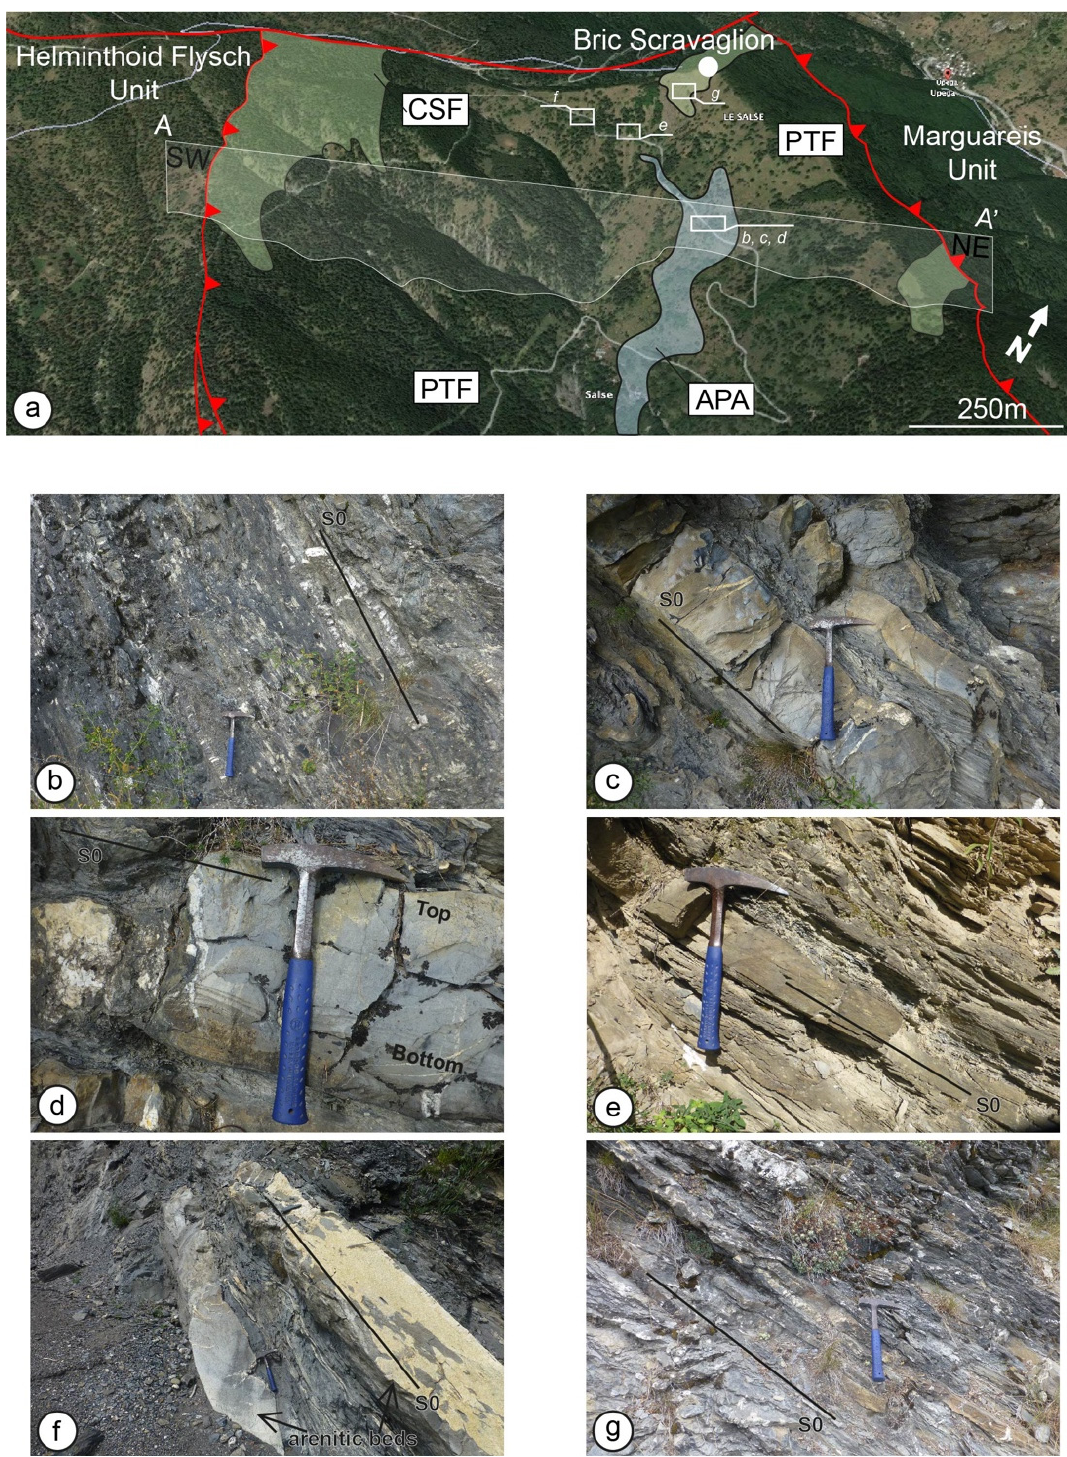
Figure 3. ( a ) 3D Image (from Google Earth Pro) showing the location of the outcrops (white boxes) of the Moglio-Testico Unit formations. The pale white SW-NE direct block indicates the orientation of the A-A’ geological cross section of Figure 2c. The pale green and blue areas indicate the boundary between the Palombini Shale (APA), the Pieve di Teco Formation (PTF) and the Cesio Foramtion (CSF); ( b – d ) Palombini Shale outcrops; ( e , f ) Pieve di Teco Formation outcrops; ( g ) Cesio Formation outcrop. S0: bedding.